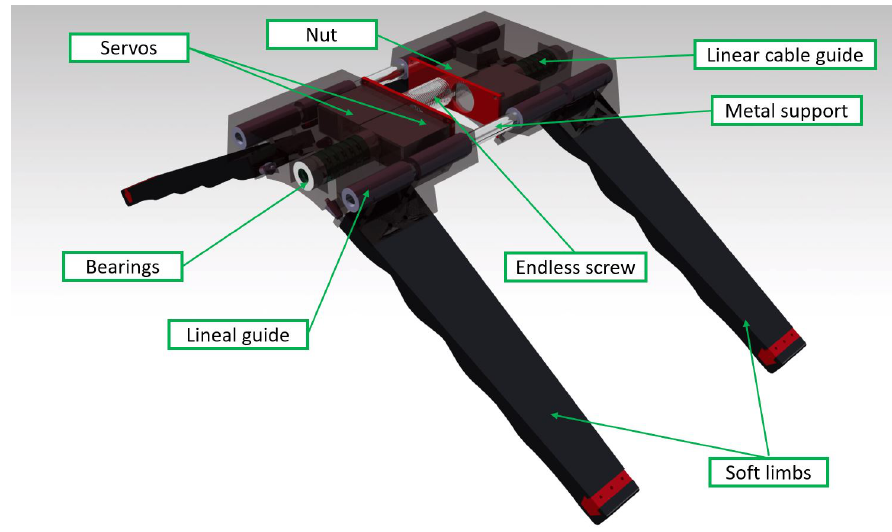
Figure 2. CAD view of the forward-motion system. The arrangement of the three servos, the worm gear, the linear bearings at the ends of the case and the guides to contracting the soft limbs can been seen.